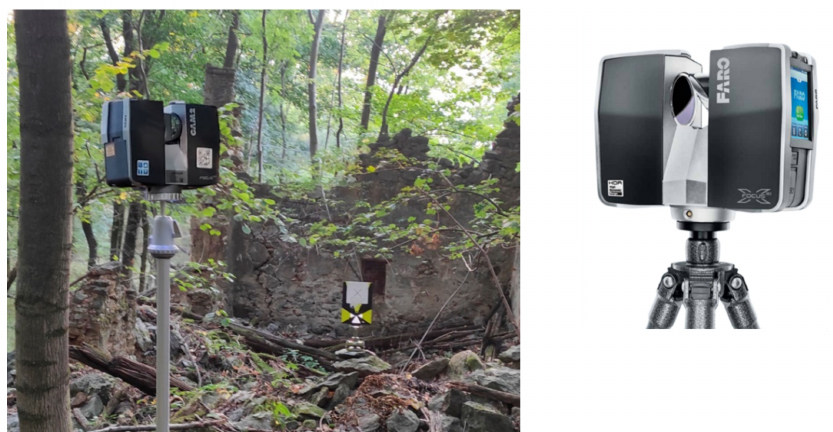
Figure 6. Faro Focus 3D X130 Terrestrial Laser Scanner device used for the detailed digitalization of the building and its environment. On the left, the laser scanner is shown during data collection and on the right the equipment in